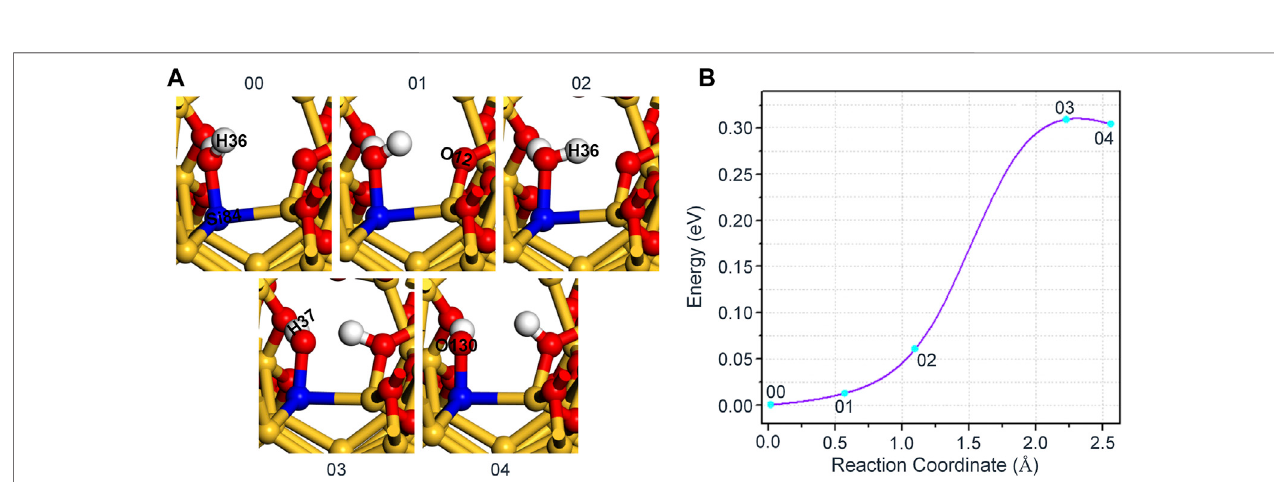
FIGURE 7 | (A) The schematic diagram of the reaction between P b1 defect and H 2 O. (B) The variation of the energy with different reaction coordinates for the reaction of H 2 O and P b1 defect with AOD con fi guration at random position 3.